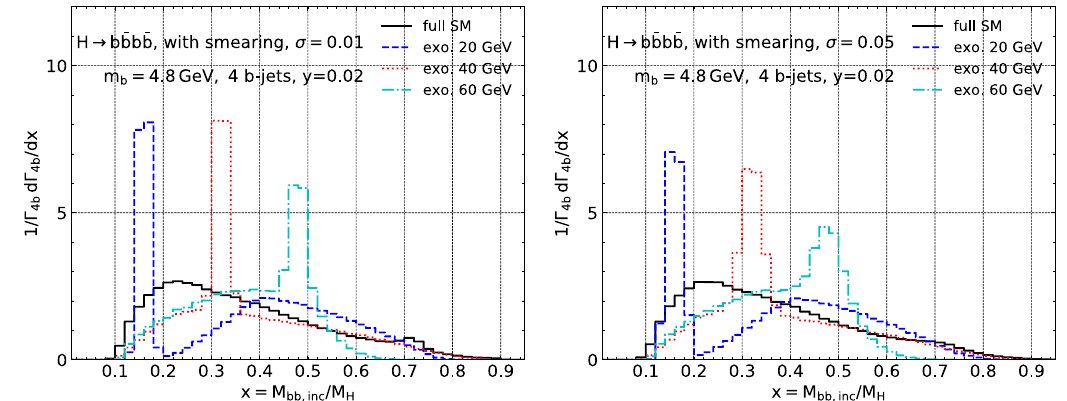
Figure 22 . Comparison on normalized distribution of the Higgs boson decay to four bottom quarks as a function of the inclusive invariant mass of all b -jet pairs, for the SM decay and exotic decay via new light scalars with different masses, assuming an energy resolution of 1% (left plot) and 5% (right plot), at NLO in QCD.